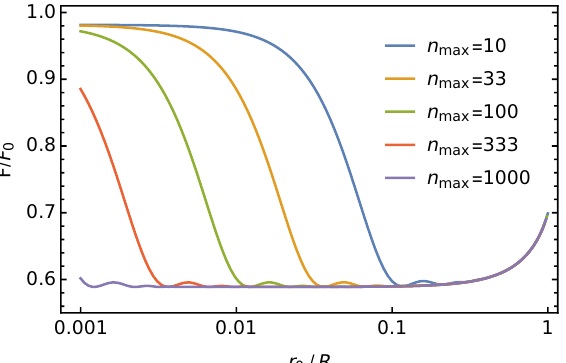
Figure 5. Scaled Debye-Hückel free energy F / F 0 according to Equation (19) as a function of relative disk size r 0 / R for fixed R / l D = 1 and ε l = ε w . Different curves correspond to n max = 10 (blue), n max = 33 (orange), n max = 100 (green), n max = 333 (red), n max = 1000